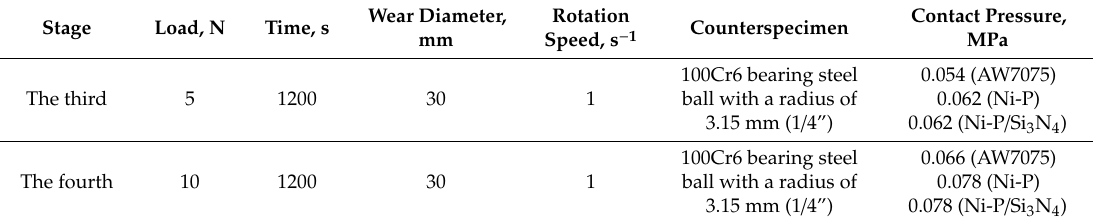
Table 3. Parameters of tribological tests (the second